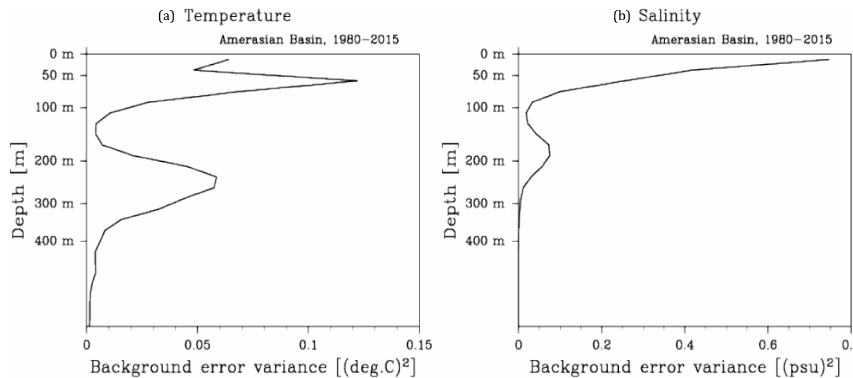
Figure 13. Vertical profile of the background mean variance, var bg , for temperature (a) and salinity (b) .